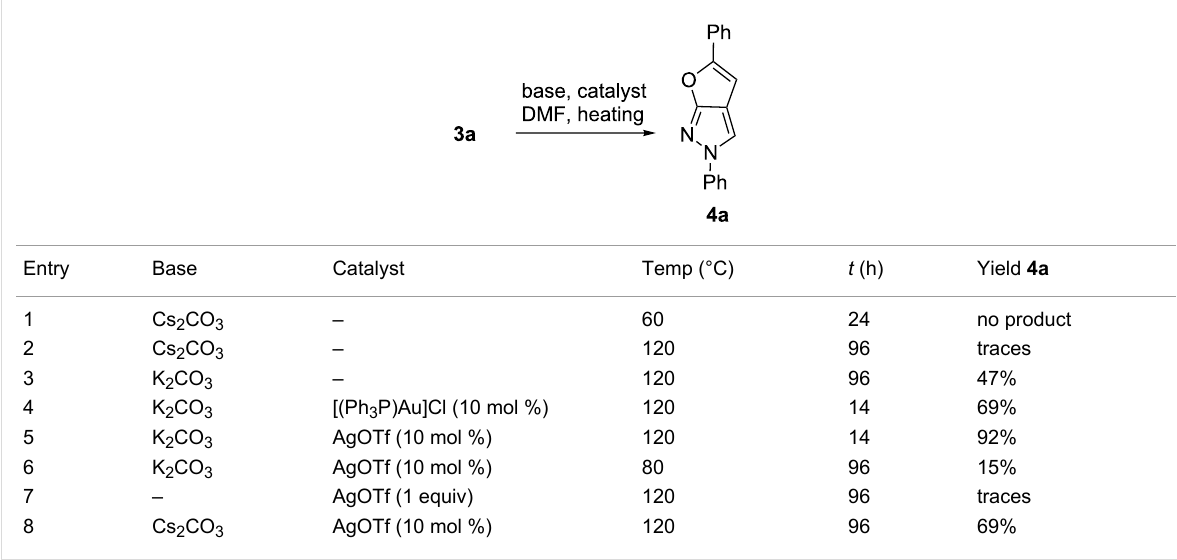
Table 1: Cyclization of compound 3a